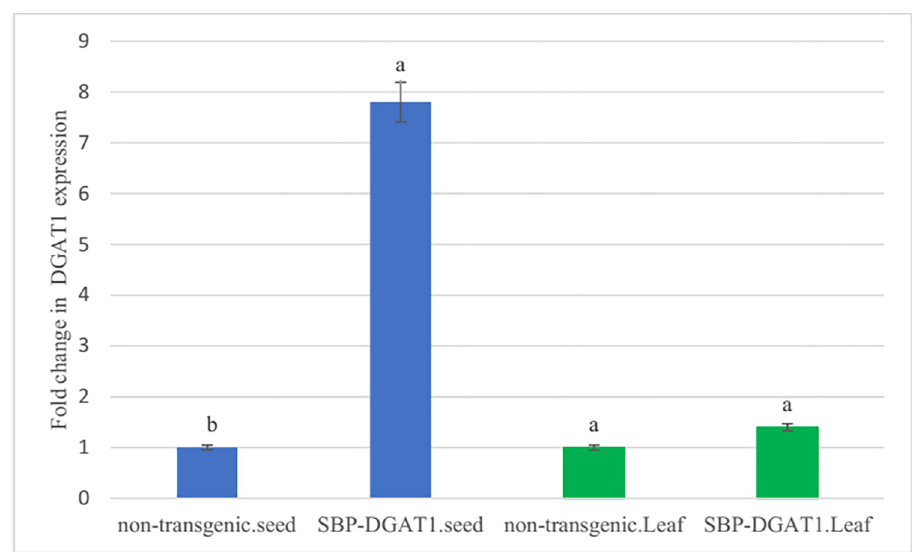
Fig 7. Functional impact of SBP promoter on mRNA levels of DGAT1 in seed and leaf of the transgenic plant (SBP-DGAT1). Relative expression levels are expressed as fold changes in blue bars: seeds and in green bars: leaves. Mean values with different letters are significantly different by one-way ANOVA (P < 0.01), n = 6.